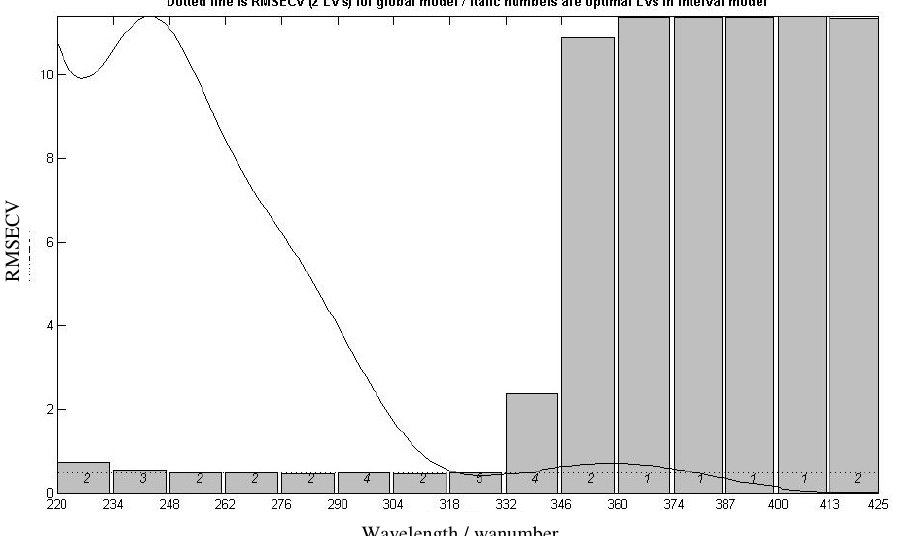
Figure 2. Cross-validated prediction errors (RMSECV) values to full-spectrum model and interval models (bars) to ATV determination using PLS and iPLS algorithms (dotted line